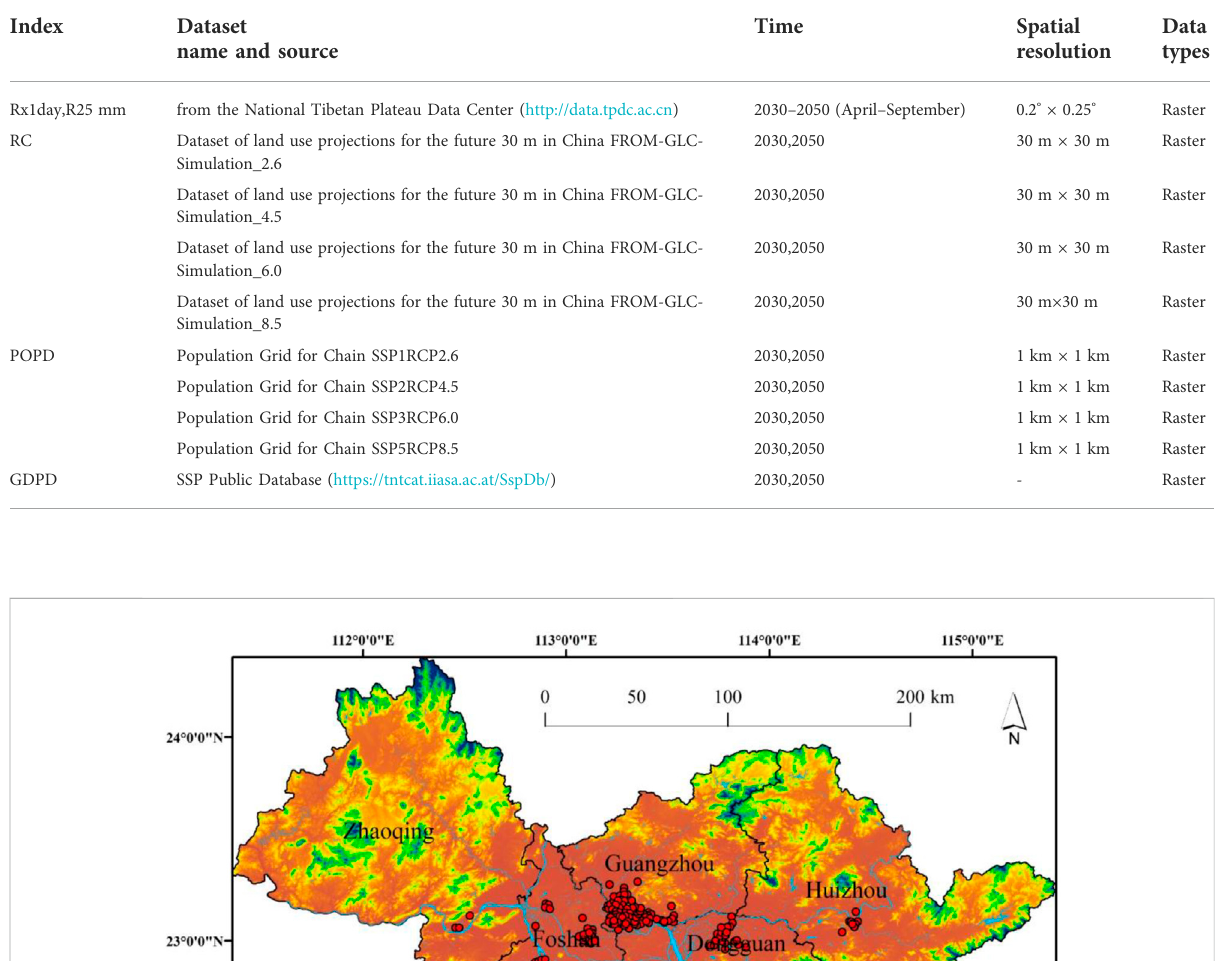
TABLE 2 The database for the future projection data.